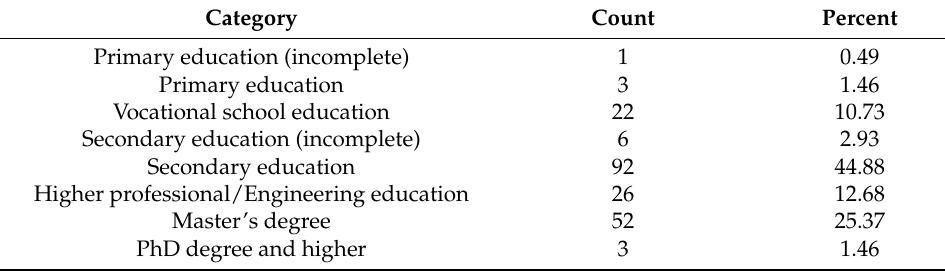
model predicting mean blood pressure changes., Table S4: Mixed linear model predicting pulse pressure changes.